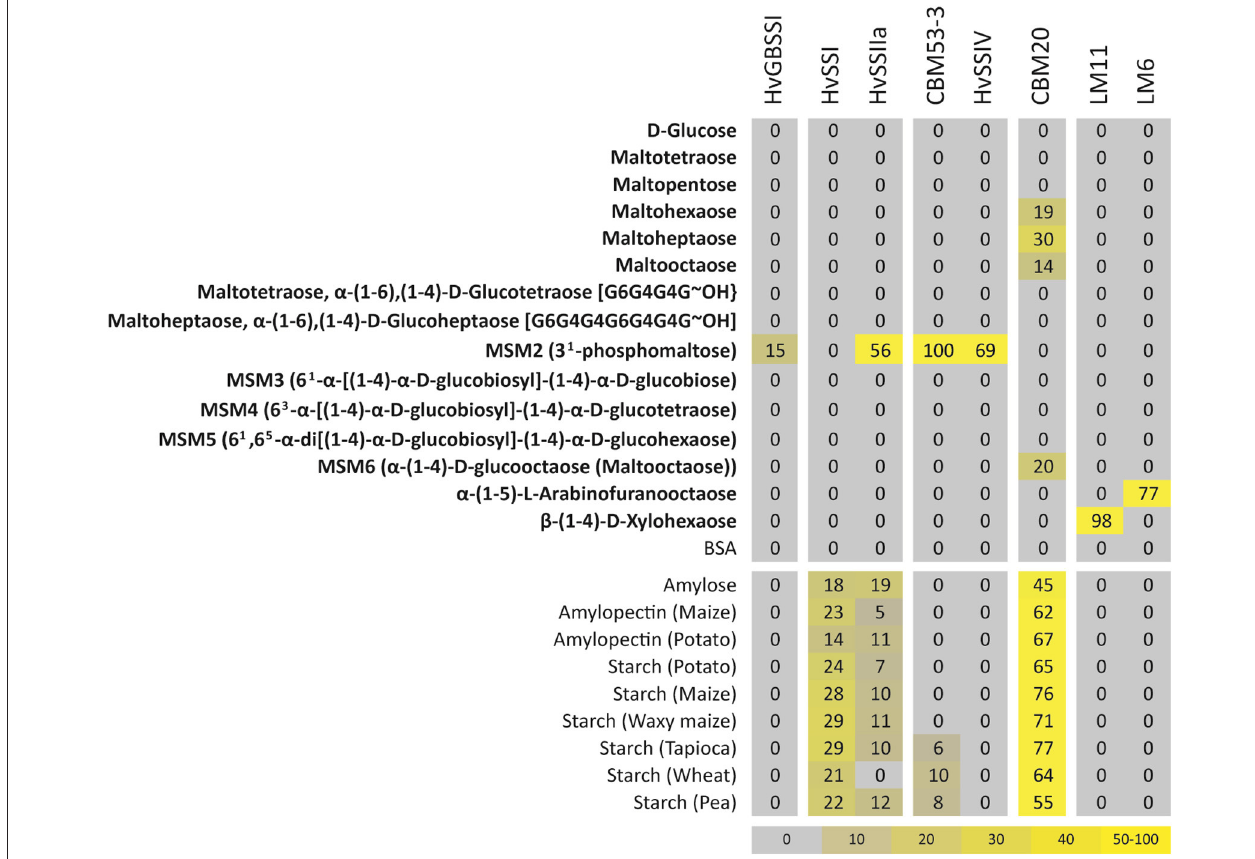
Frontiers in Plant Science |